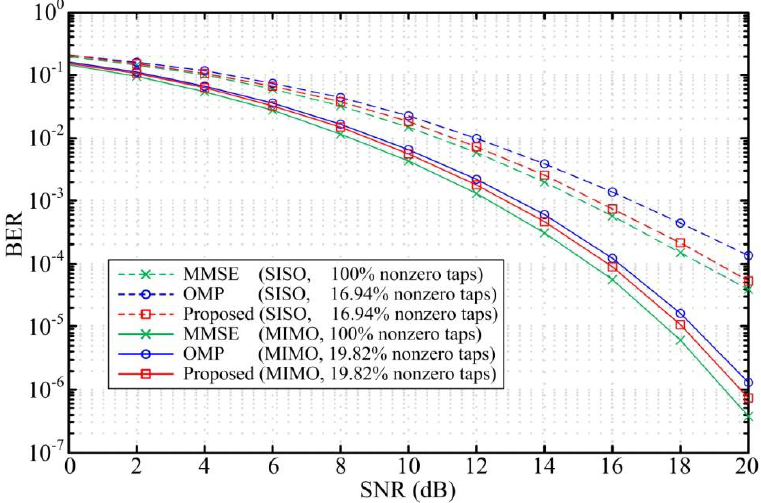
Figure 3. BER versus SNR for SISO DFE and MIMO DFE in the Vehicular A channel with η max = 0.6 dB and N f = 50.